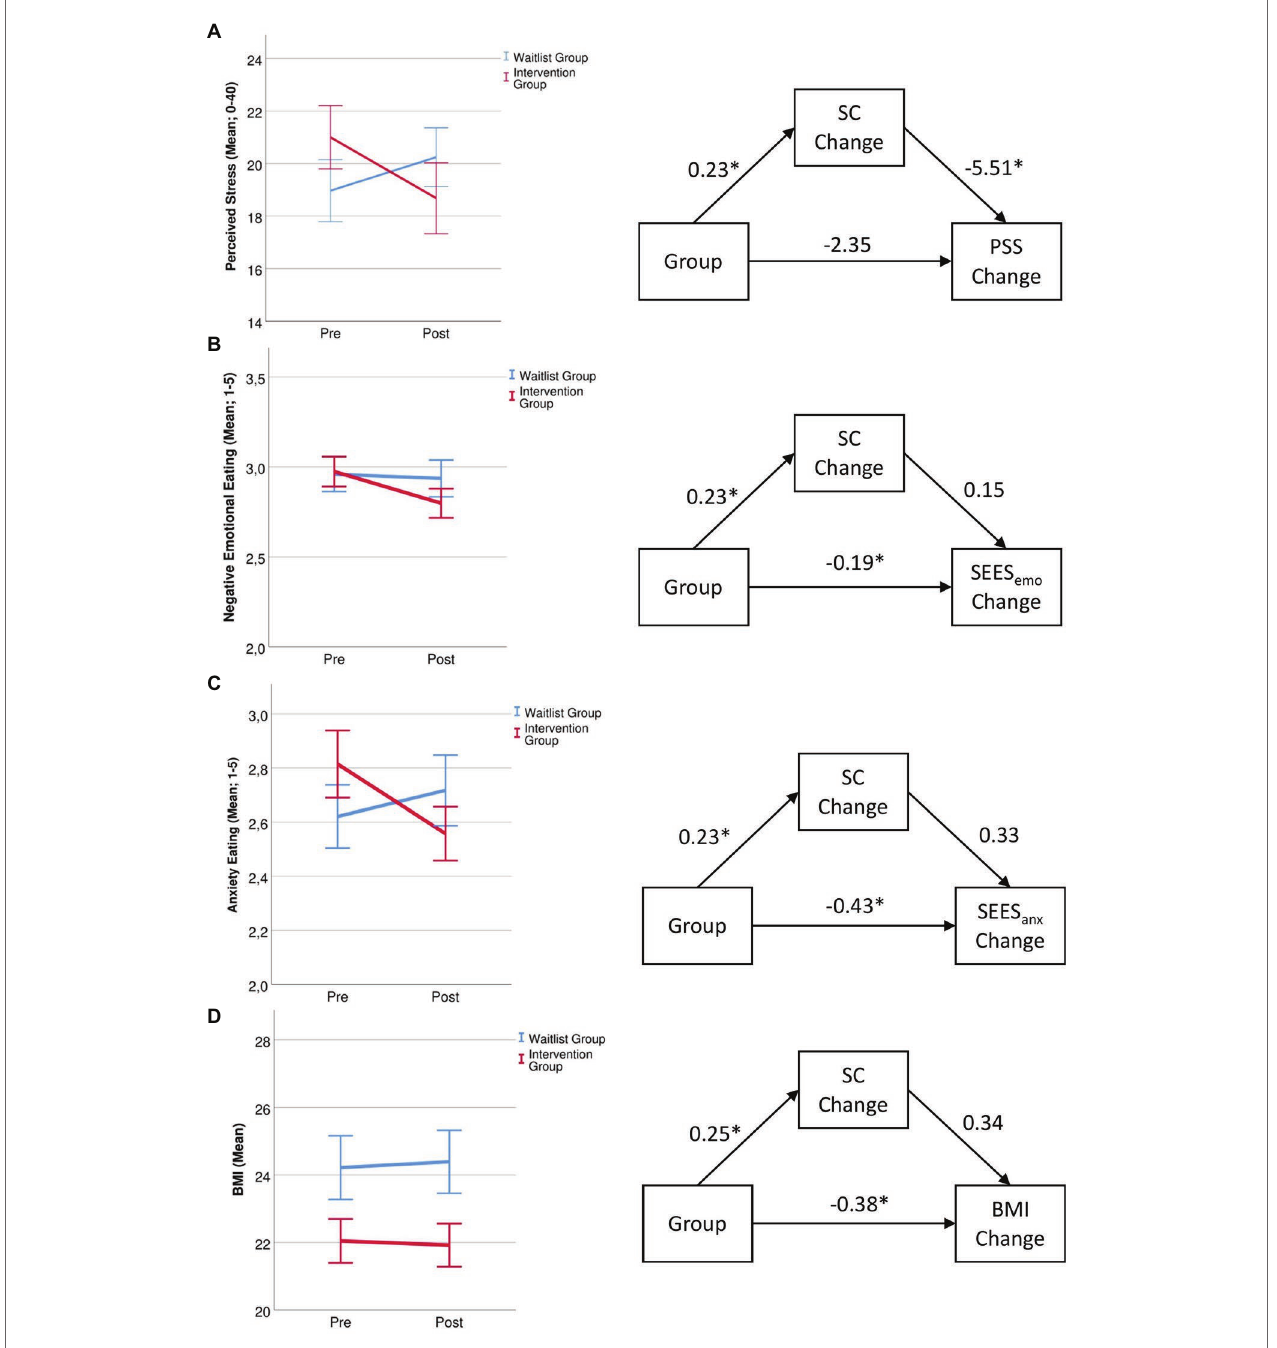
FIGURE 3 | Changes in (A) , perceived stress, (B) , eating in response to negative emotions, (C) , eating in response to anxiety, and (D) , body mass index (BMI) for the waitlist and intervention group before and after the 14-day intervention and mediating role of self-compassion for these changes with correlation coefficients. * = p < 0.05, SC, self-compassion; PSS, perceived stress scale; SEES emo, Salzburg emotional eating scale (overall emotional eating); SEES anx, Salzburg emotional eating scale (anxiety eating subscale); and BMI, body mass